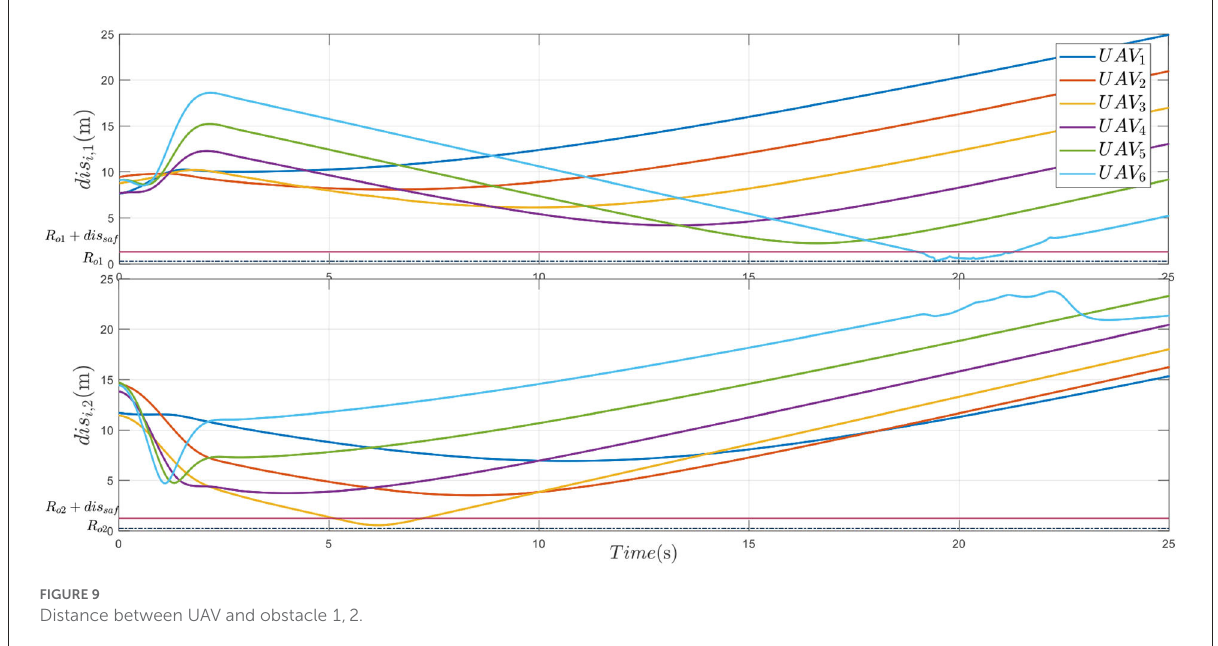
FIGURE9 Distance between UAV and obstacle 1,2.